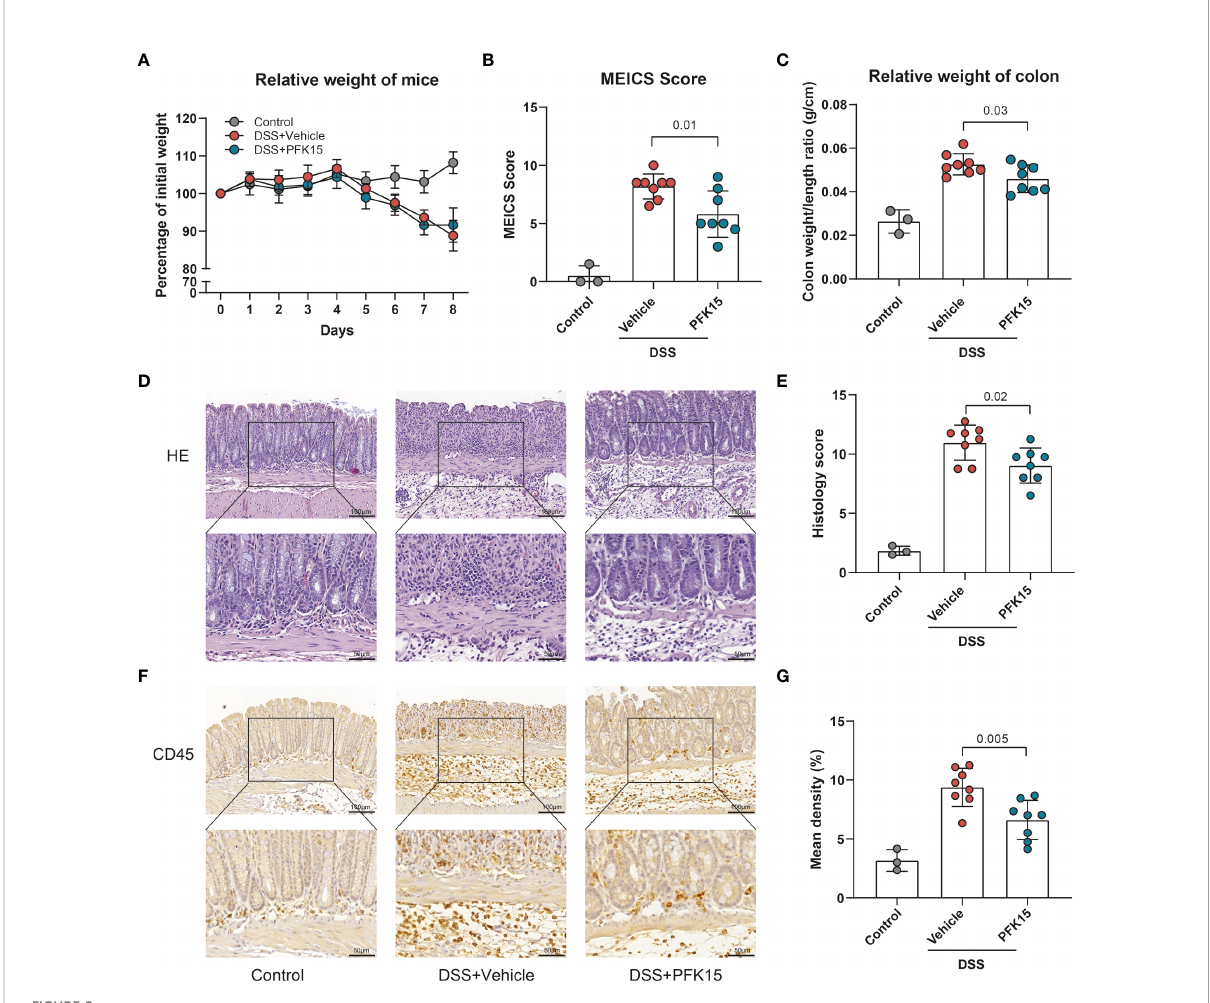
FIGURE 8 Inhibition of PFKFB3 attenuated in fl ammation in DSS-induced colitis. Mice received 1.75% DSS (n=3 control, n=16 DSS) at the start of the experiment. From day 1, DSS mice were treated with PFK15 (25mg/kg) or DMSO (n=8/group) every three days. (A) Body weight of mice was measured daily and expressed as the percentage of body weight on day 0. (B) MEICS score of the mice on day 8. (C) Colon weight/length ratio (g/cm) of the mice. (D) Representative hematoxylin and eosin staining of the colon. (E) Quanti fi cation of IBD histology score of the colon. (F) Representative immunohistochemical stainings of immune cell marker CD45. (G) Quanti fi cation of the percentage of CD45 positive stained area. Unpaired two-tailed t-test was performed to assess statistical signi fi cance between vehicle treated and PFK15 treated mice. Scale bar, 100 m m (upper panel) or 50 m m (lower